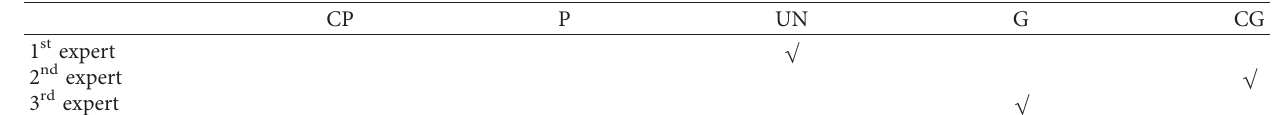
Table 2: Evaluation result of C1.